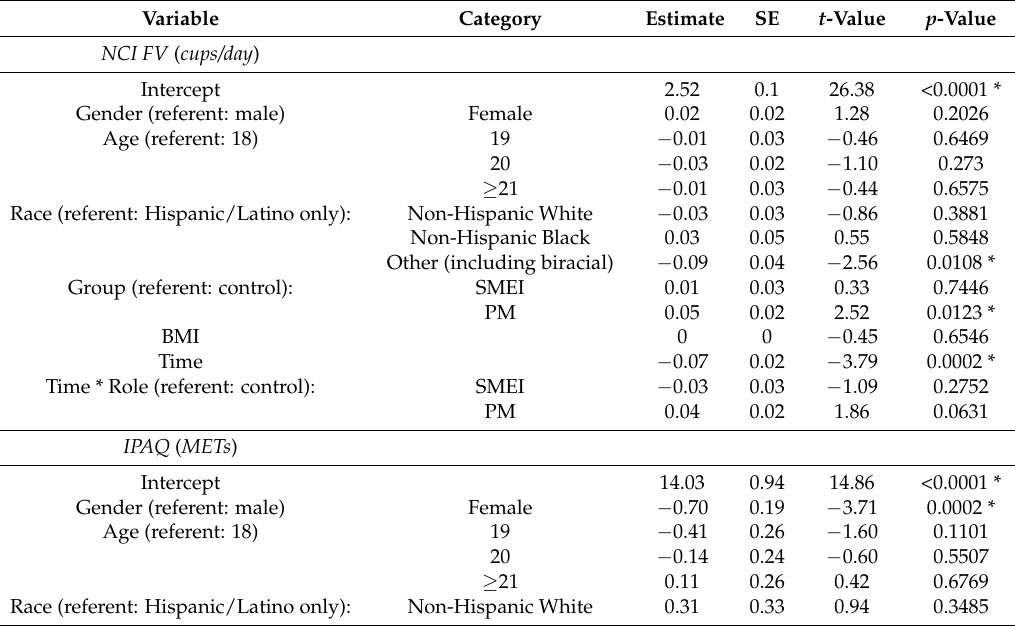
Table 3. Mixed Regression Models for